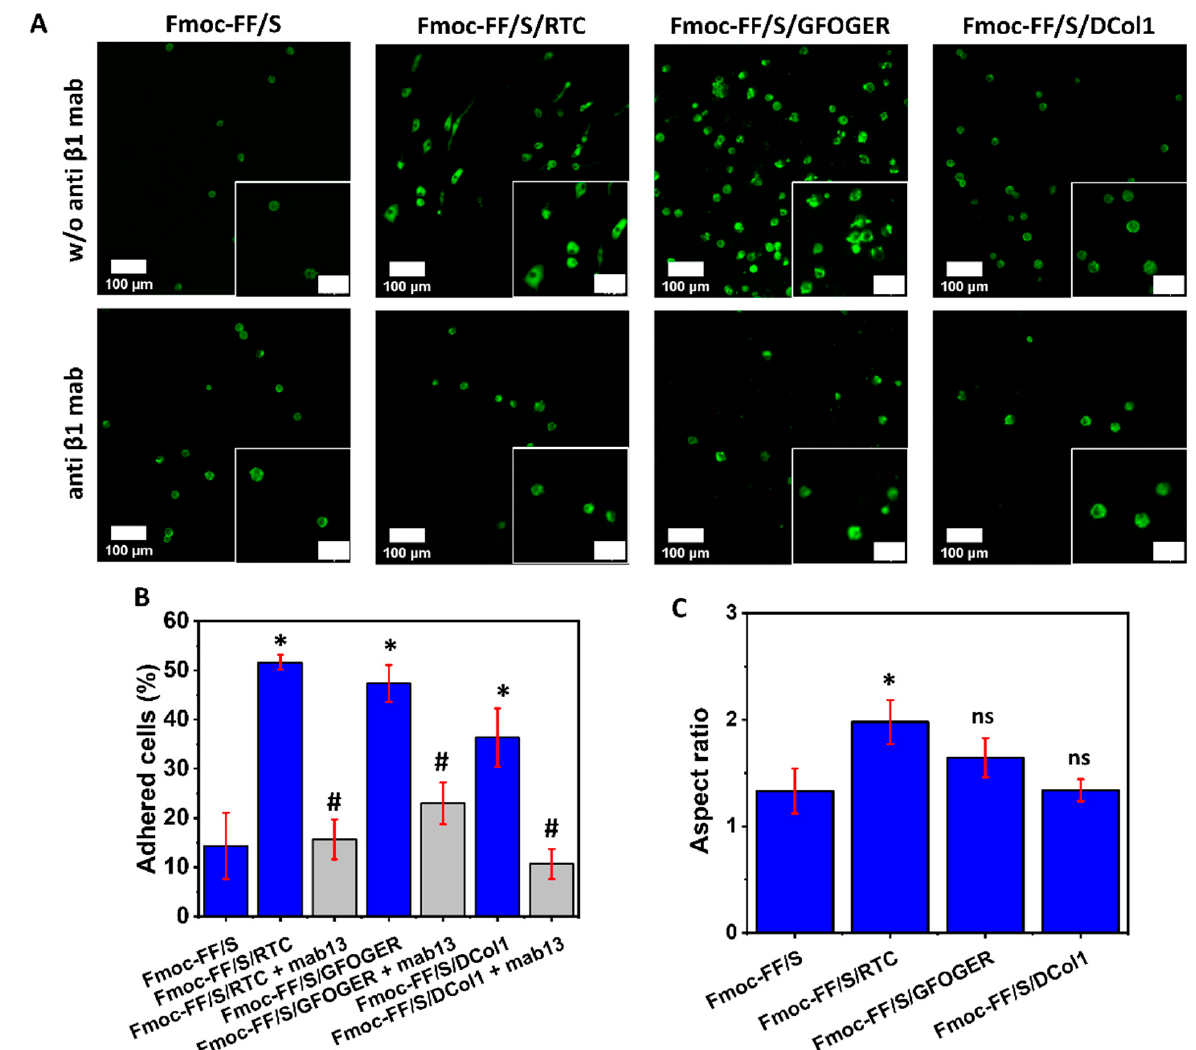
Figure 6. HT1080 cell adhesion and cell spreading. ( A ) F-actin staining of HT1080 cells after 24 h culture on the different collagen hydrogels (green: F-actin, Alexa Fluor 488 phalloidin; scale bars 100 µm, inset 50 µm) with and without pre-incubation with mAb13 (anti β 1) antibody. ( B ) Analysis of cell adhesion on the different collagen-modified hydrogels without (blue bars) and with (grey bars) pre-incubation with mAb13 antibody. ( C ) Spread HT1080 cells show a mean aspect ratio above 1 while rounded shaped cells are reflected by an aspect ratio 1. Data shown as mean ± SD, n = 43, */# p < 0.05, ns (not significant). Significance for each group is relative to Fmoc-FF/S (*), with the exception of groups shown in the grey columns which are in comparison to their respective blue columns (#).